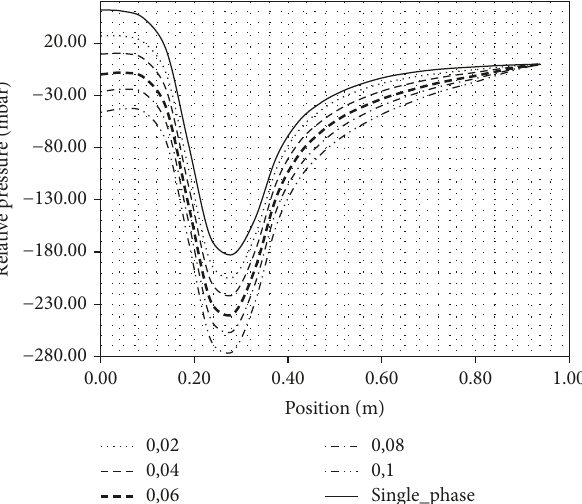
Figure 19: Pressure distribution at maximum mass flow rate for different Ar volume